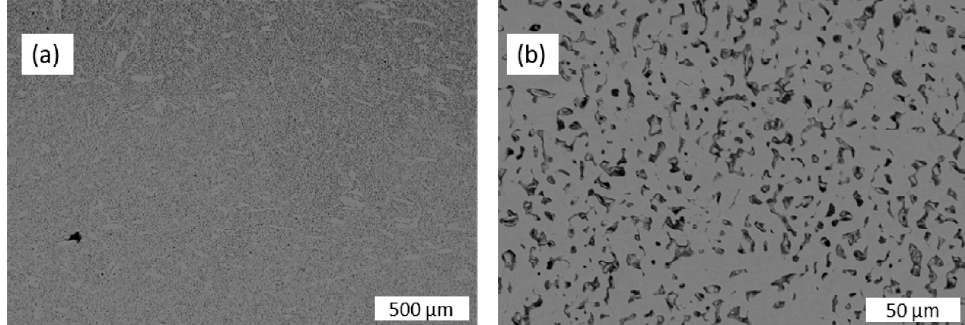
Fig. 3. SEM microphotos of the Specimen 1 after forging. Magnification (a) x50, (b) x500.